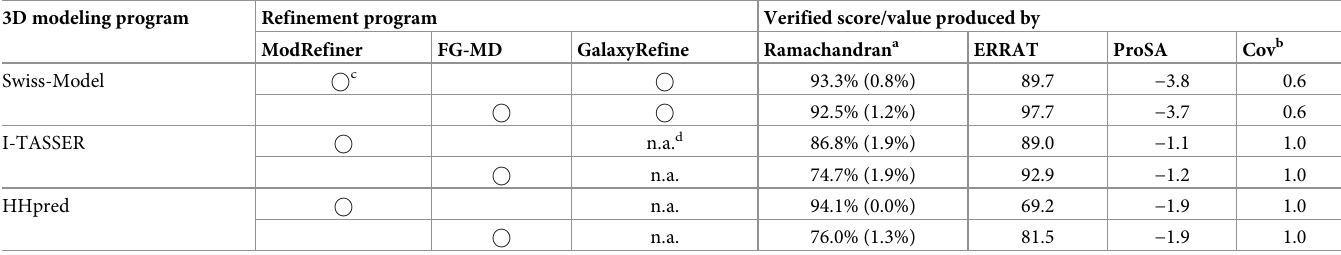
Table 2. Comparison on refined structural